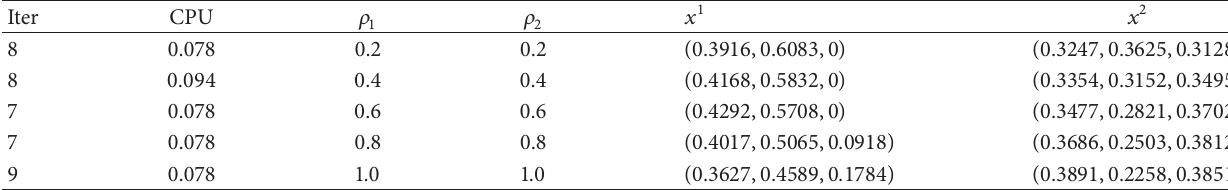
Table 3: Robust Nash equilibria with various choices of uncertainty